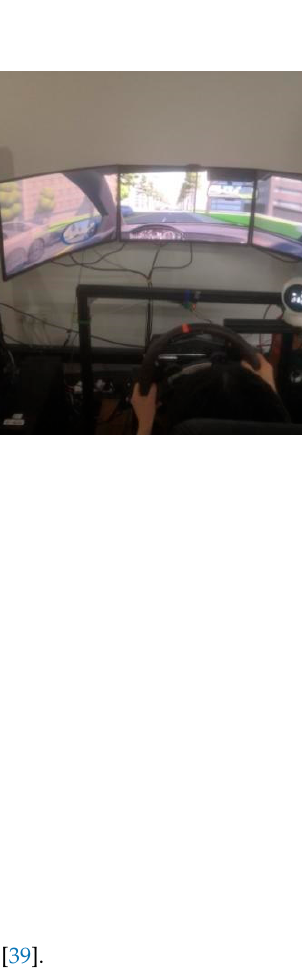
Figure 6. Expression design set used on robot’s face screen [39].